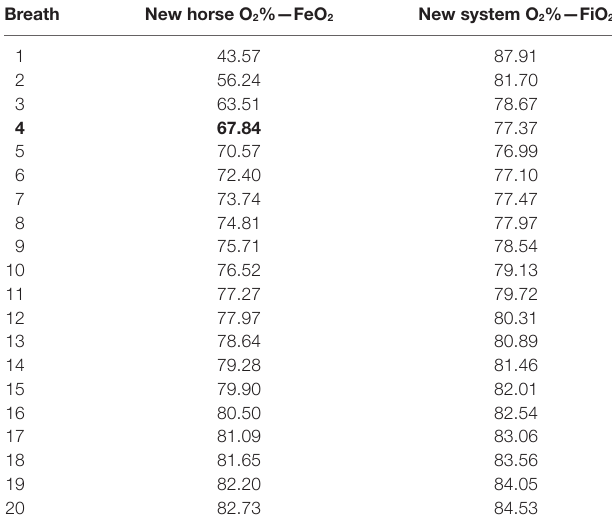
Table 4 | Modeling of